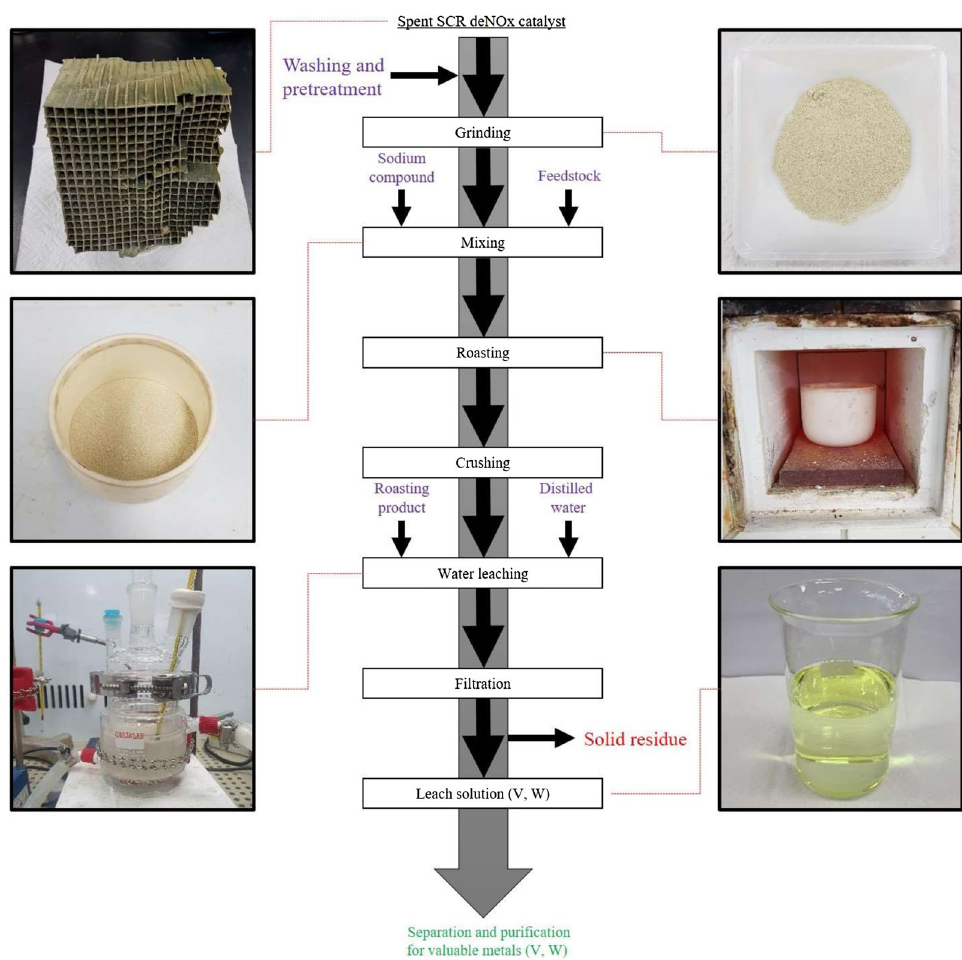
Figure 9. Eco- friendly hydrometallurgical process flowsheet for spent SCR DeNO x catalyst